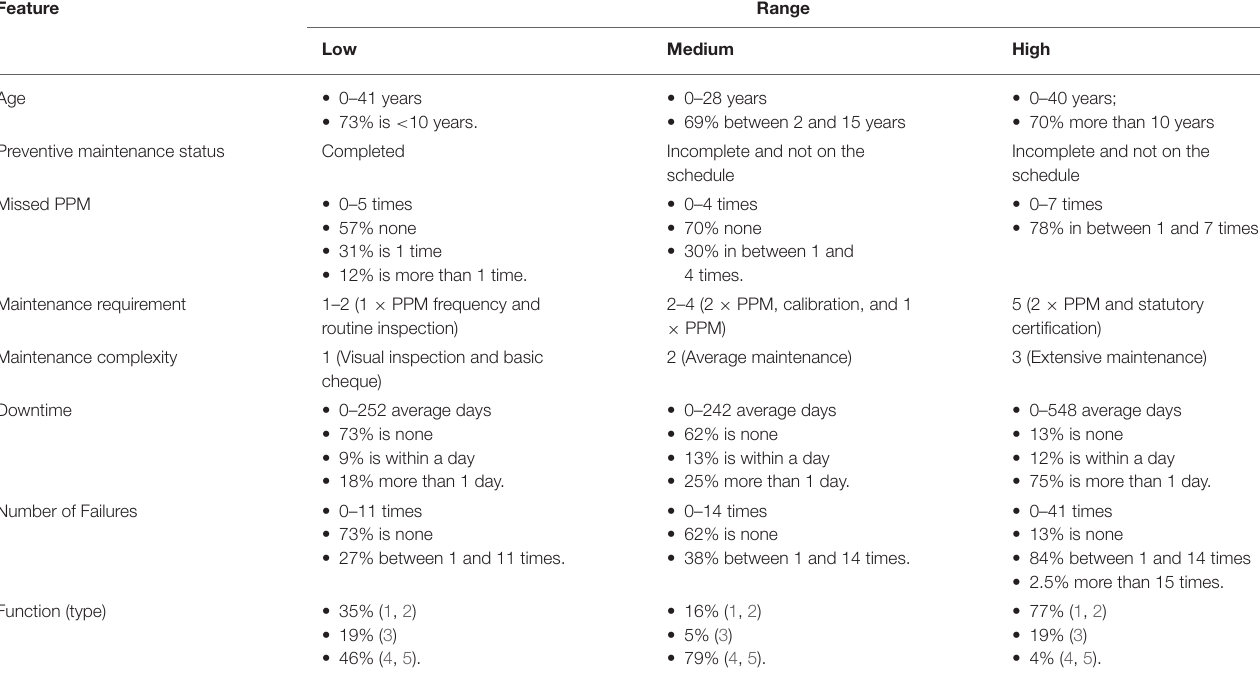
TABLE 7 | Findings of preventive maintenance prioritisation